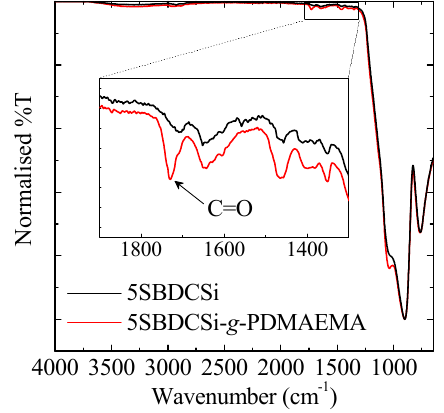
Figure 1. IR spectrum of a 5SBDCSi film on a glass substrate after performing a SI-PIMP of DMAEMA for 4 h in the presence of a SI (red trace) in comparison to a 5SBDCSi film on a glass substrate (black trace). The free polymer was characterised by 1 H NMR (58% monomer conversion, DP n,th 15, M n,th 2520 g · mol − 1 ) and SEC ( M n,SEC 3420 g · mol − 1 , M w,SEC 5575 g · mol − 1